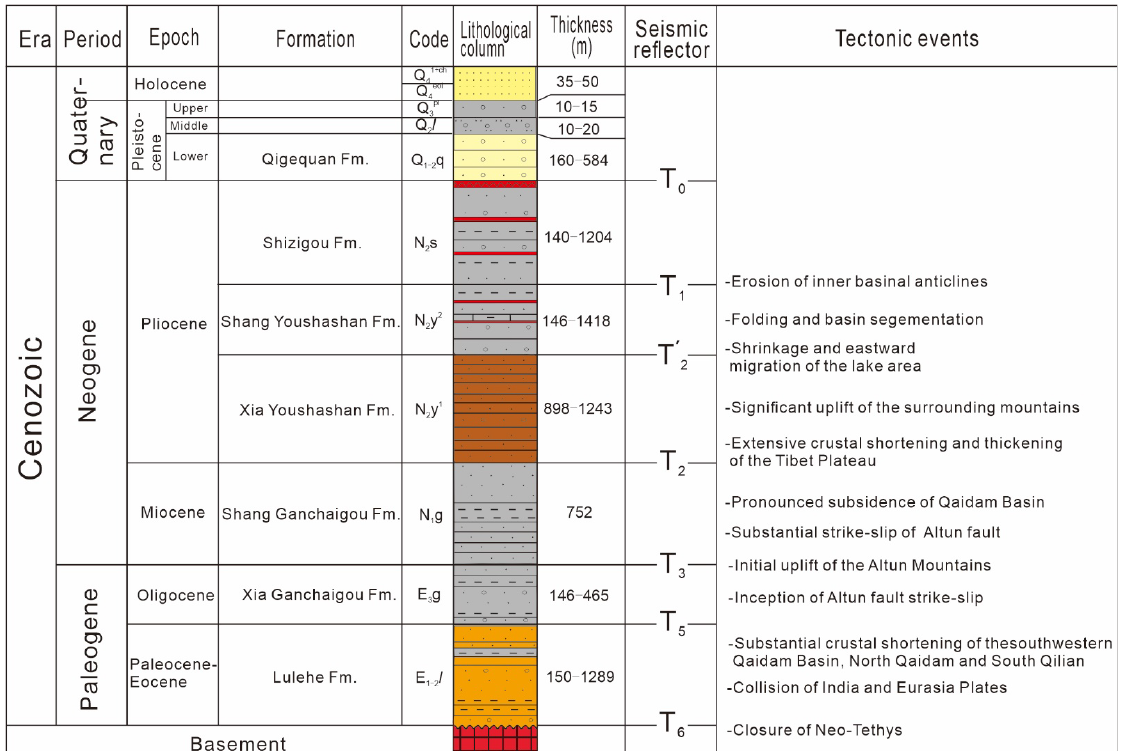
Figure 3. Cenozoic stratigraphical framework and seismic reflectors of the southwestern area of the Qaidam Basin (modified after [69,71,72]). Detailed regional tectonic events see